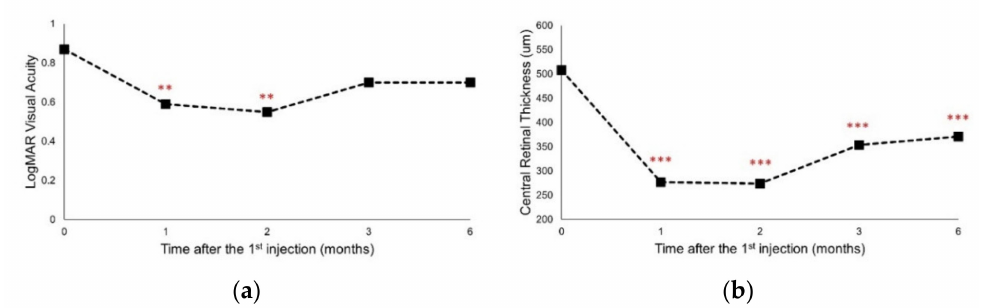
Figure 1. The change in ( a ) LogMAR visual acuity and ( b ) central retinal thickness from baseline after the 1st intravitreal dexamethasone implantation at different time points. Values represent mean ± SD. p < 0.05 were considered statistically different. ** p < 0.01, *** p <